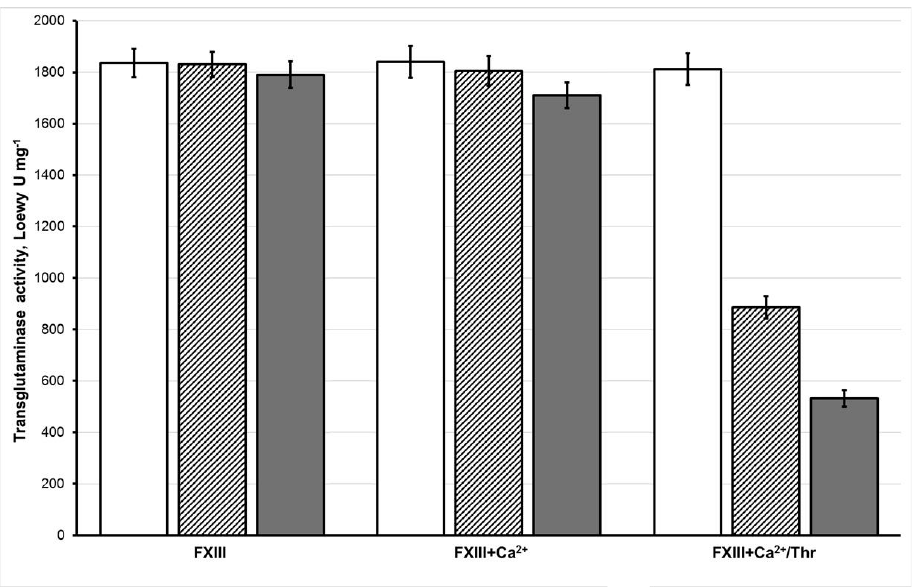
Figure 2. The transglutaminase activity values (Loewy U mg − 1 ) for the various FXIII samples subjected to 50 μ M (hatched columns) and 150 μ M (gray columns) hypochlorite and for non-oxidized FXIII (white columns). The transglutaminase activity is expressed as the means ± S.D., n = 6.